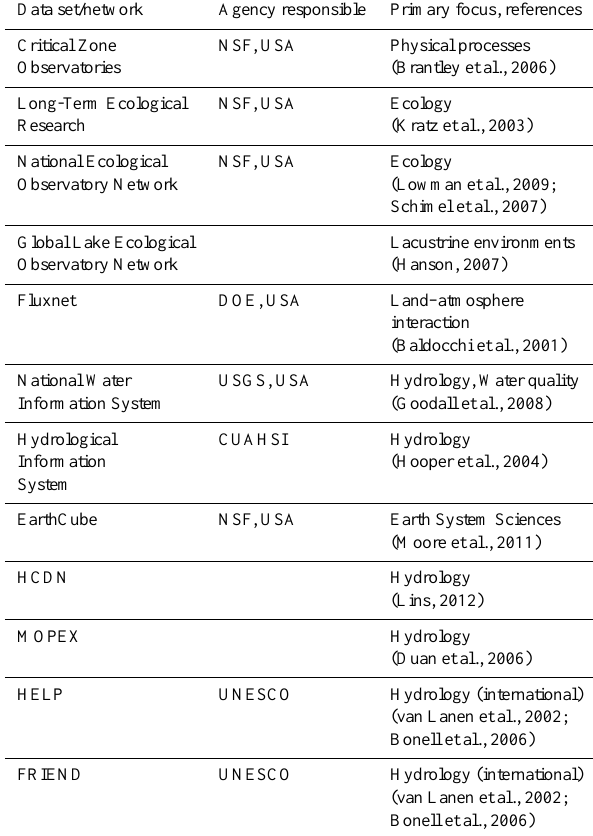
Table 2. Existing data networks that are relevant to hydrological